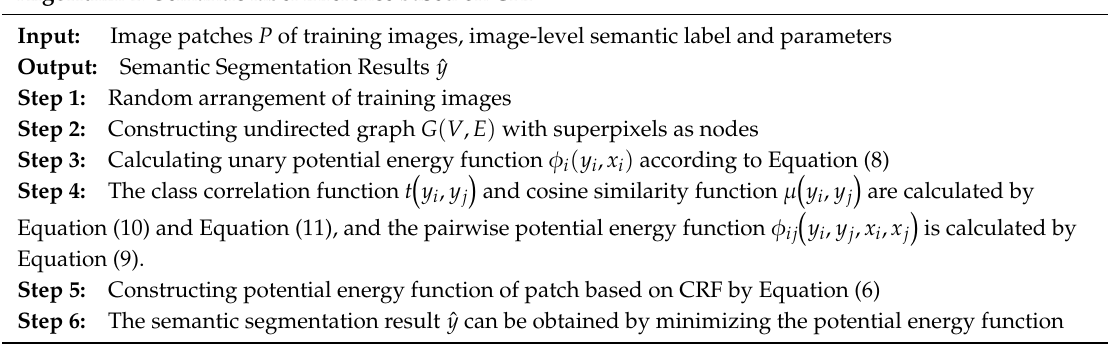
Algorithm 1 : Semantic label inference based on CRF